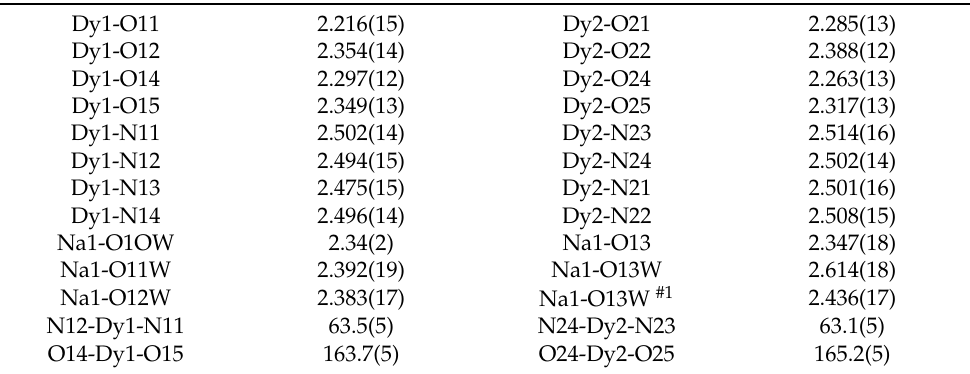
Table 1. Main bond distances (Å) and angles (º) for 1.